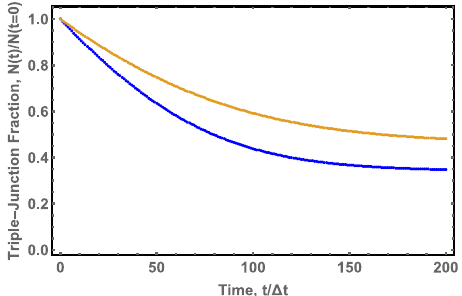
Fig. 8 The time dependence of the coarse-grained triple-junction fraction for an evolving microstructure. The evolution of the triple- junction fraction, N ( t )/ N ( t = 0), as a function of reduced time, Δ t , for the coarse-grained grain-growth model for two applied fi elds, = 1.0 (blue) and ψ = 3.0 (gold). The applied fi eld leads to a ψ 0 0 reduction in the triple-junction fraction and partially controls the rate of